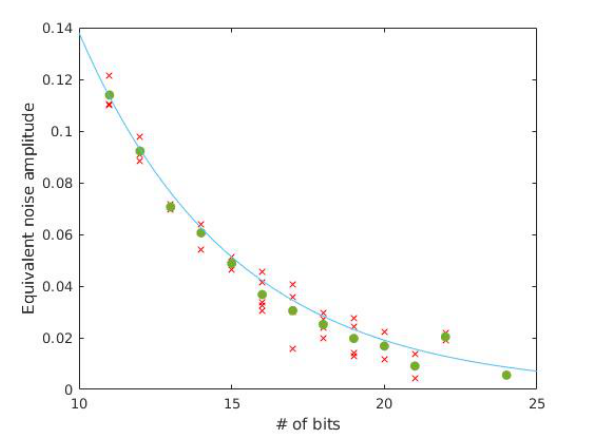
Figure 6. Equivalent noise amplitude for different number of bits. The red x correspond to the noise level of a single simulation; the green o are the average of all the simulations with a given number of bits; the blue line is the fitting of the averages according to Equation (9), with η =